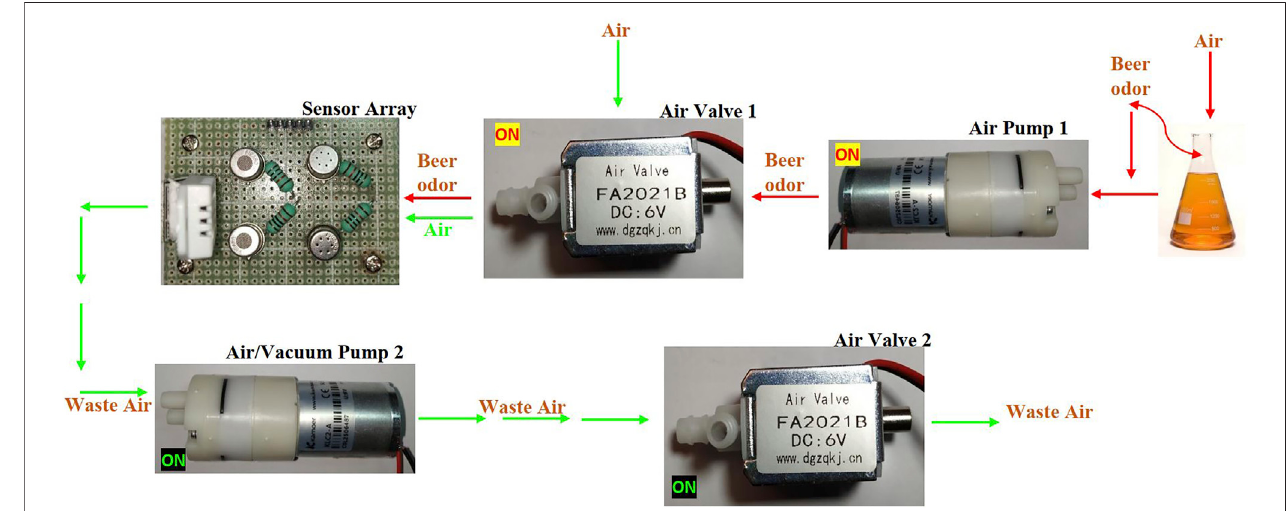
FIGURE 1 | Working modes of sample delivery